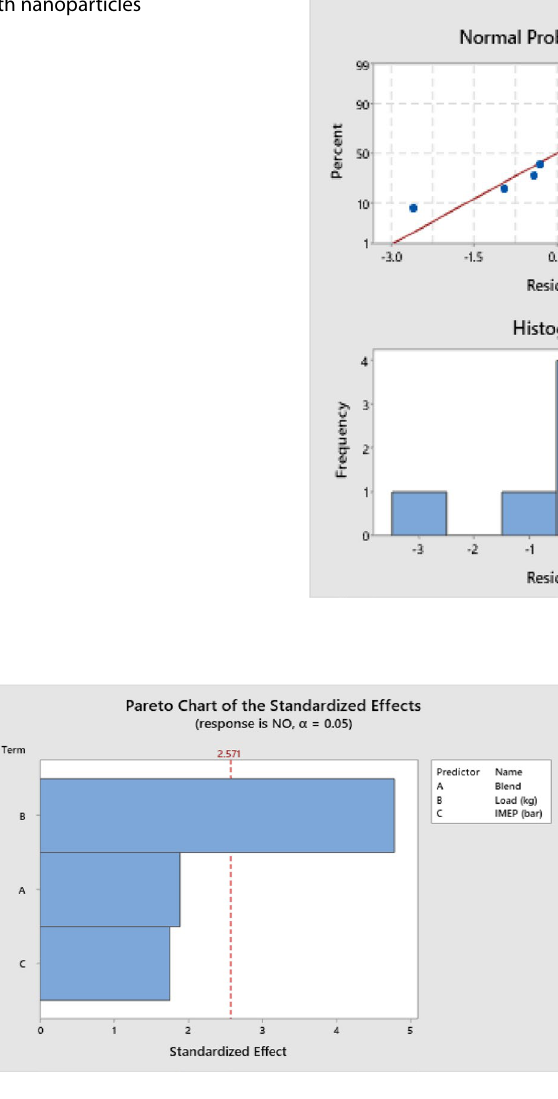
Fig. 20 Regression analysis: NOx versus blend, load (kg), IMEP (bar) without nanoparticles